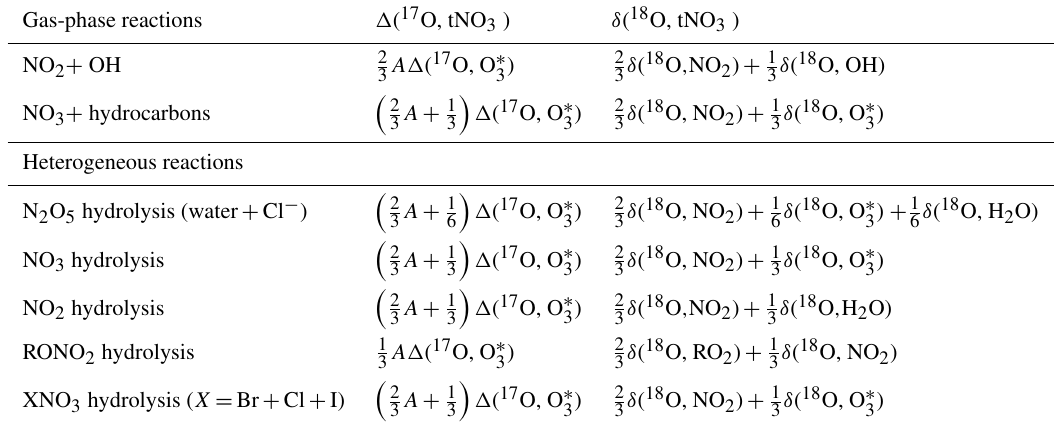
Table 1. Equations for δ ( 18 O) and (cid:49) ( 17 O) calculations by different nitrate formation pathways. Gas-phase